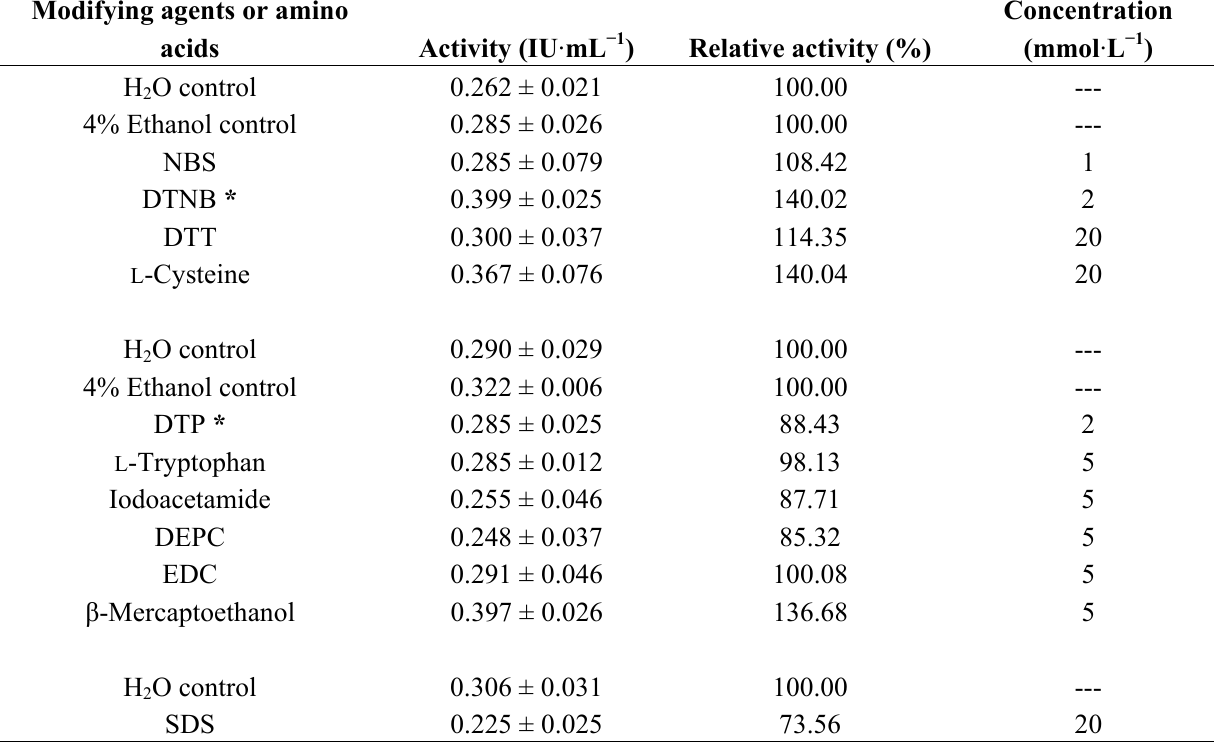
Table 3. Effect of modifying agents and amino acids on the xylanolytic activity of purified Xyl-O1. Modifying agents or amino acids Activity (IU · mL − 1